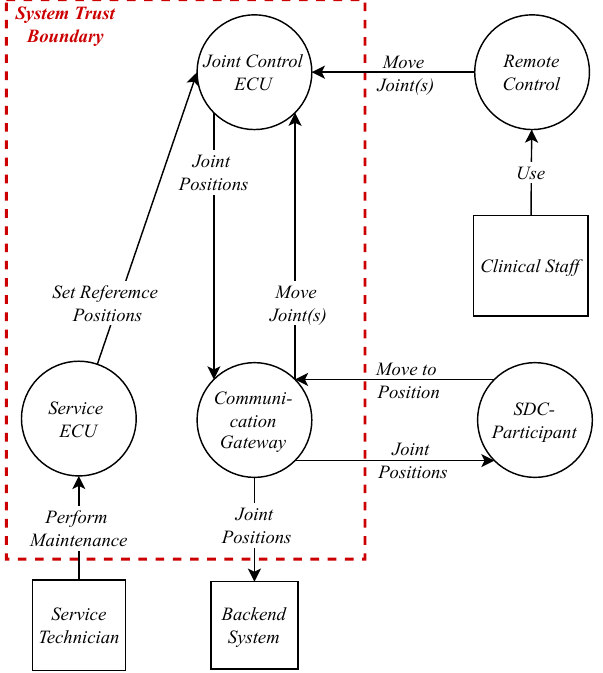
Figure 6. DFD for joint positions of an interoperable OR